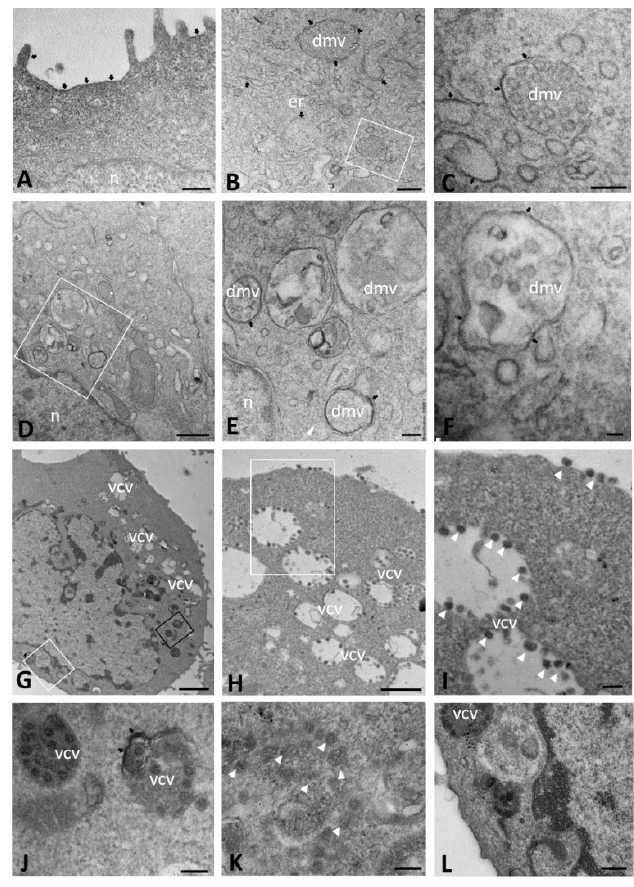
Figure 7. Immuno-electron microscopy showing ACE2 localization in mock-infected ( A ) and SARS- CoV-2-infected CFBE41o- WT cells at 24 ( B – C ), 48 ( D – F ) and 72 ( G – L ) hours post infection. The boxed areas in ( B , D , H ) are enlarged in ( C , E , I ), respectively. In ( G ), the black boxed area is enlarged in ( J ) and the white boxed area is enlarged in ( L ). (dmv): double-membrane vesicle; (n): nucleus; (vcv): virion-containing vesicle. Arrowheads indicate virions. Arrows demarcate ACE2 immunoreactivity. Bars: ( G ) 1 µm; ( D , H ) 500 nm; ( A , B , L ) 200 nm; ( C , E , I – K ) 100 nm; ( F ) 50 nm.